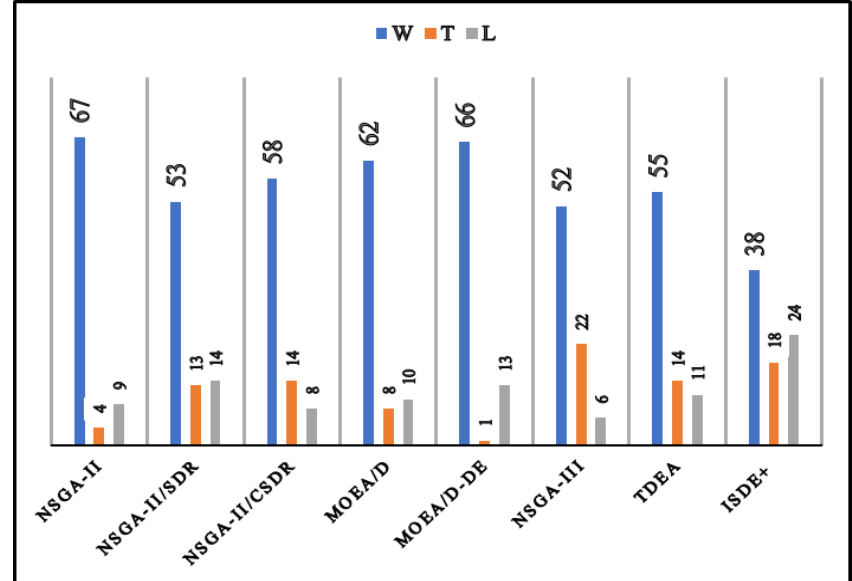
Figure 6. Comparison of NSGA-III* with other state-of-the-art algorithims.